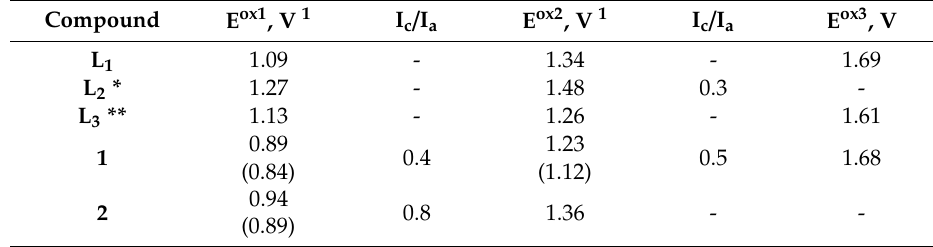
Table 2. The CV data for thioethers L 1 – L 3 and triphenylantimony(V) catecholates 1 and 2 in CH 3